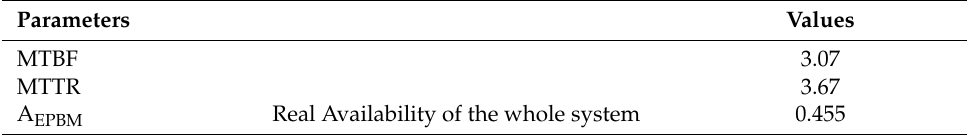
Figure 5. The TBF and TTR of the machine for the whole system. Table 5. Real MTBF, MTTR, and availability values in Line 1.